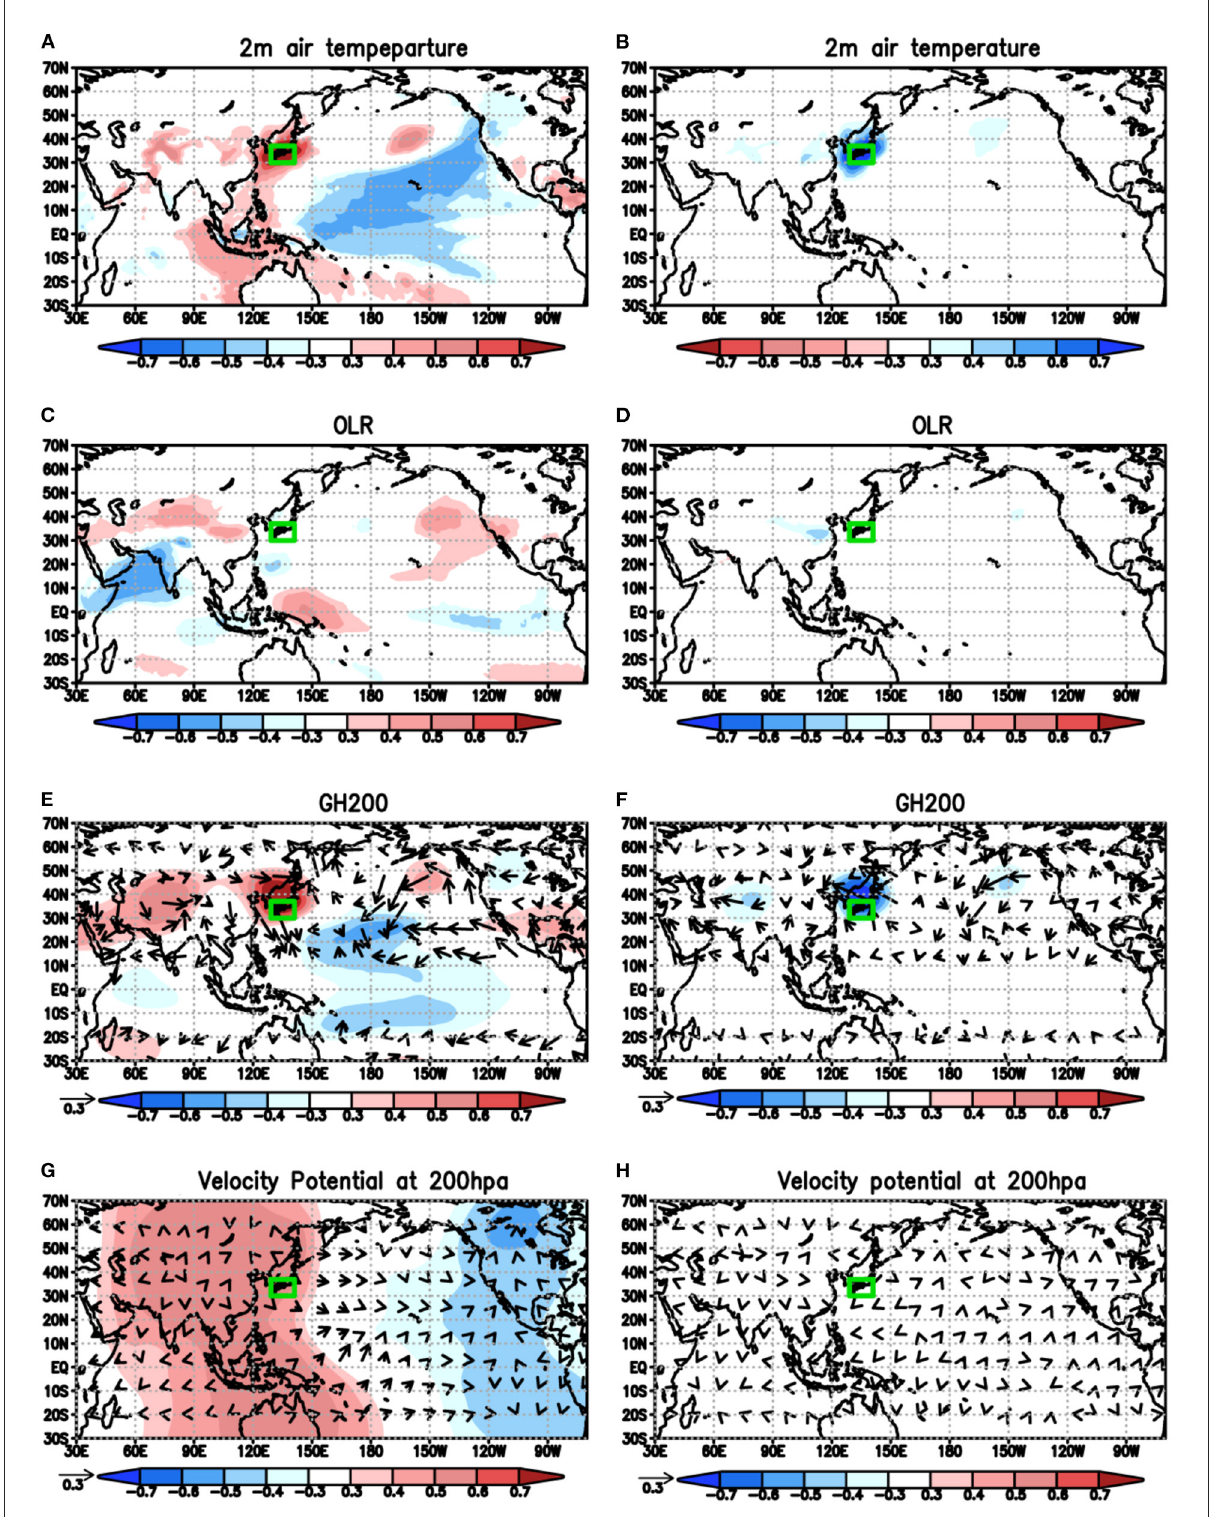
FIGURE3 (A) A horizontal map of inter-ensemble correlations between 2m-air temperature anomaly averaged in 129 ◦ E − 141 ◦ E, 30 ◦ N − 37 ◦ N (shown by the green box) and a horizontal map of 2m-air temperature anomaly in 108-member ensemble predictions for September of the 5 warm years (1998, 1999, 2007, 2010, and 2019) issued on 1st − 9th of August [sample size: 540, 12 (ensemble members) × 9 (initialized dates, 1st − 9th) × 5 (warm years)]. Considering that the degree of freedom is based on the sample size, a correlation beyond 0.3 is statistically significant at the